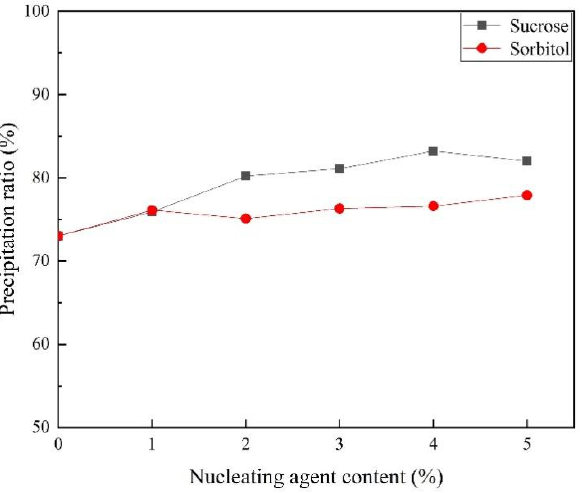
Figure 5. The relationship between nucleating agent content and the precipitation